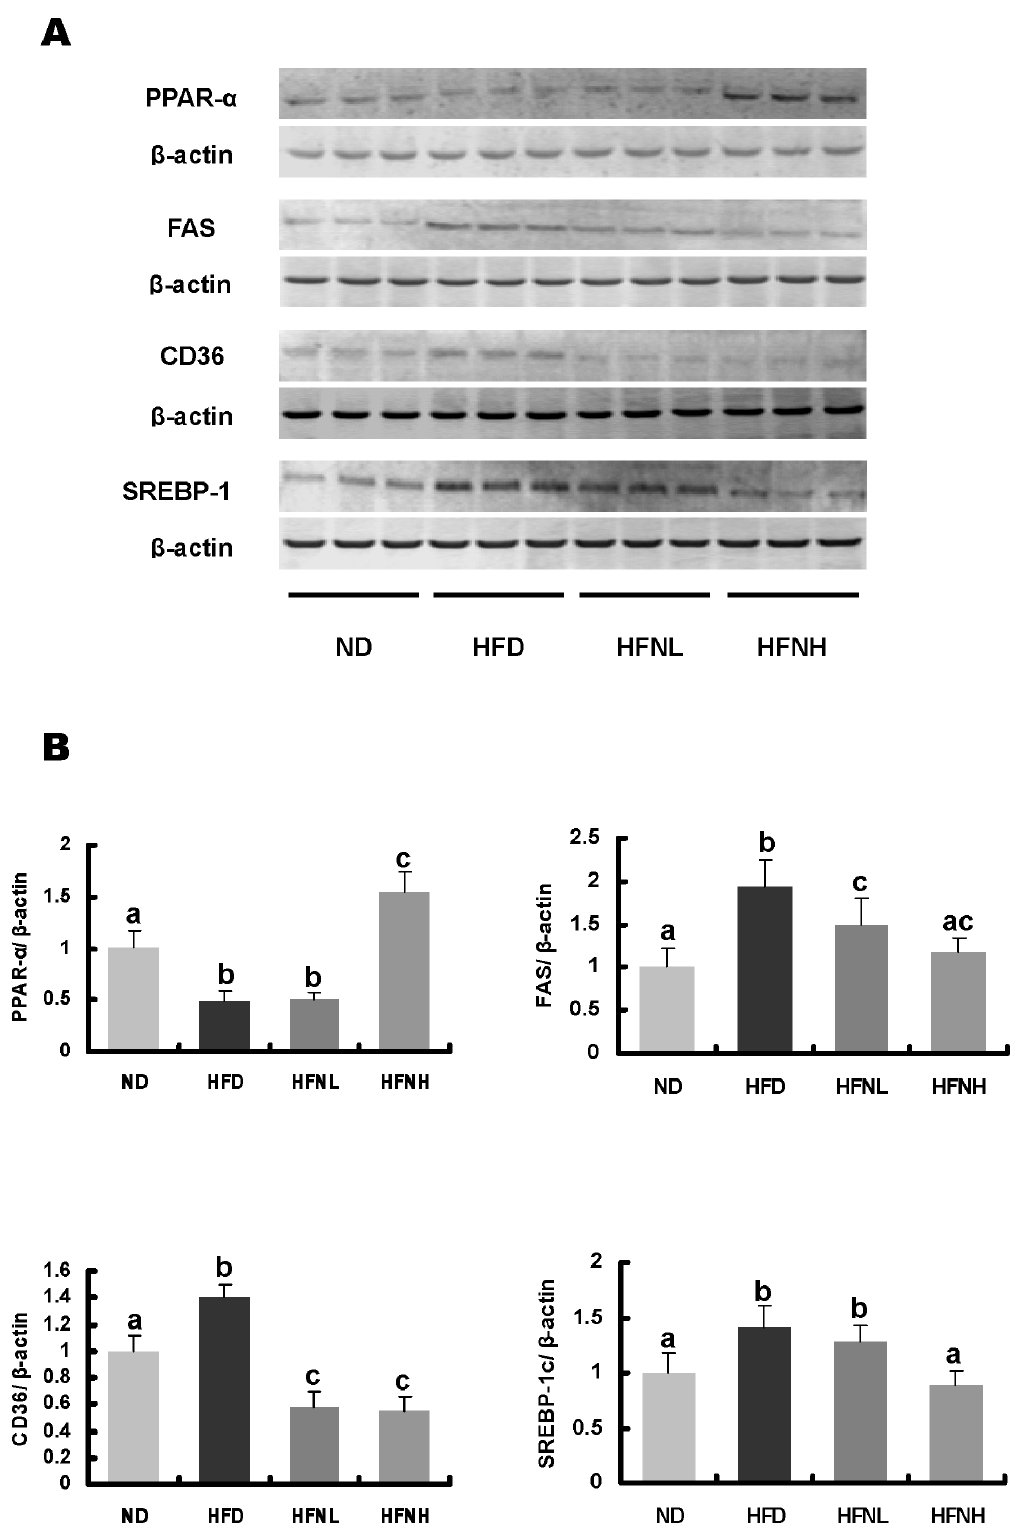
Figure 4. Effecs of nuciferine on hepatic protein levels of PPAR- a , CD36, FAS and SREBP-1c in high-fat fed hamsters. (A) Representative immunoblot showing the analysis of each protein. (B) Data graphed from image densitometric analysis of blots obtained from tissues of 10 separate animals (n=10). ND: normal diet group, HFD: HFD group, HFNL: low dosage nuciferine group (HFD + 10 mg/kg ? BW/day), HFNH: high dosage nuciferine group (HFD + 15 mg/kg ? BW/day). a, b, c, d: Means in the same row with different online letters differ significantly, p , 0.05.